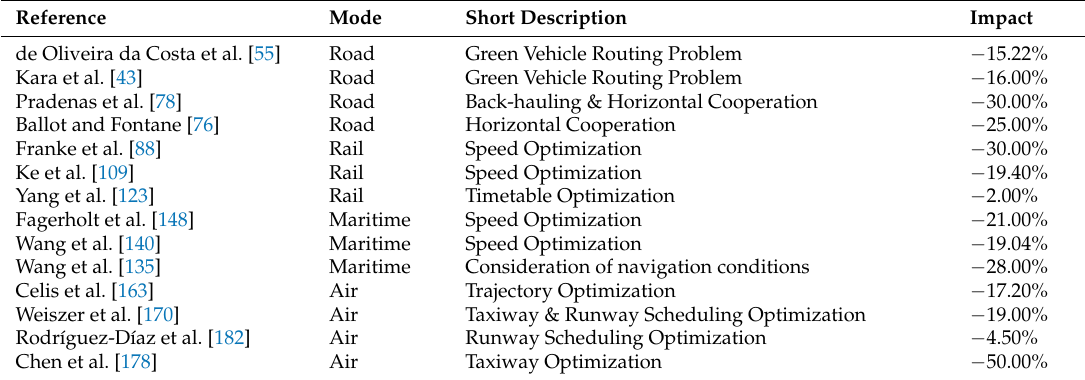
Table 8. Scientific articles quantifying the impact of OR methods on energy